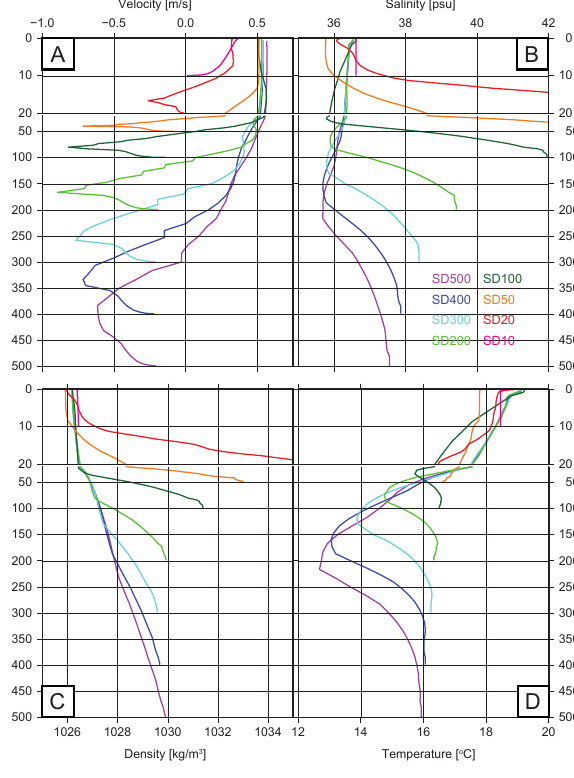
Figure 10. Vertical profiles of zonal velocity (a) , salinity (b) , den- sity (c) and temperature (d) at the sill in the Strait of Gibraltar in ex- periments SD500–SD10. Note the change in vertical scale at 20m. Temperature and salinity profiles of SD50 stand out with incongru- ent values near the surface. This is caused by a numerical overshoot due to steep slopes near the gateway in this